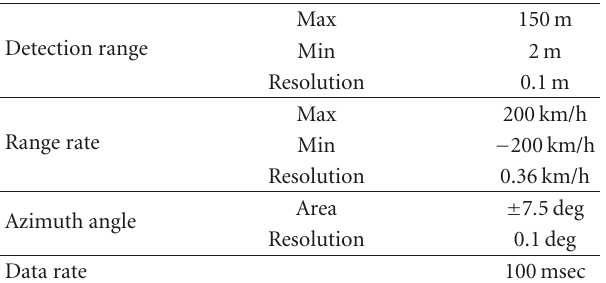
Figure 4: View of the Millimeter Wave Radar. Table 1: Millimeter Wave Radar